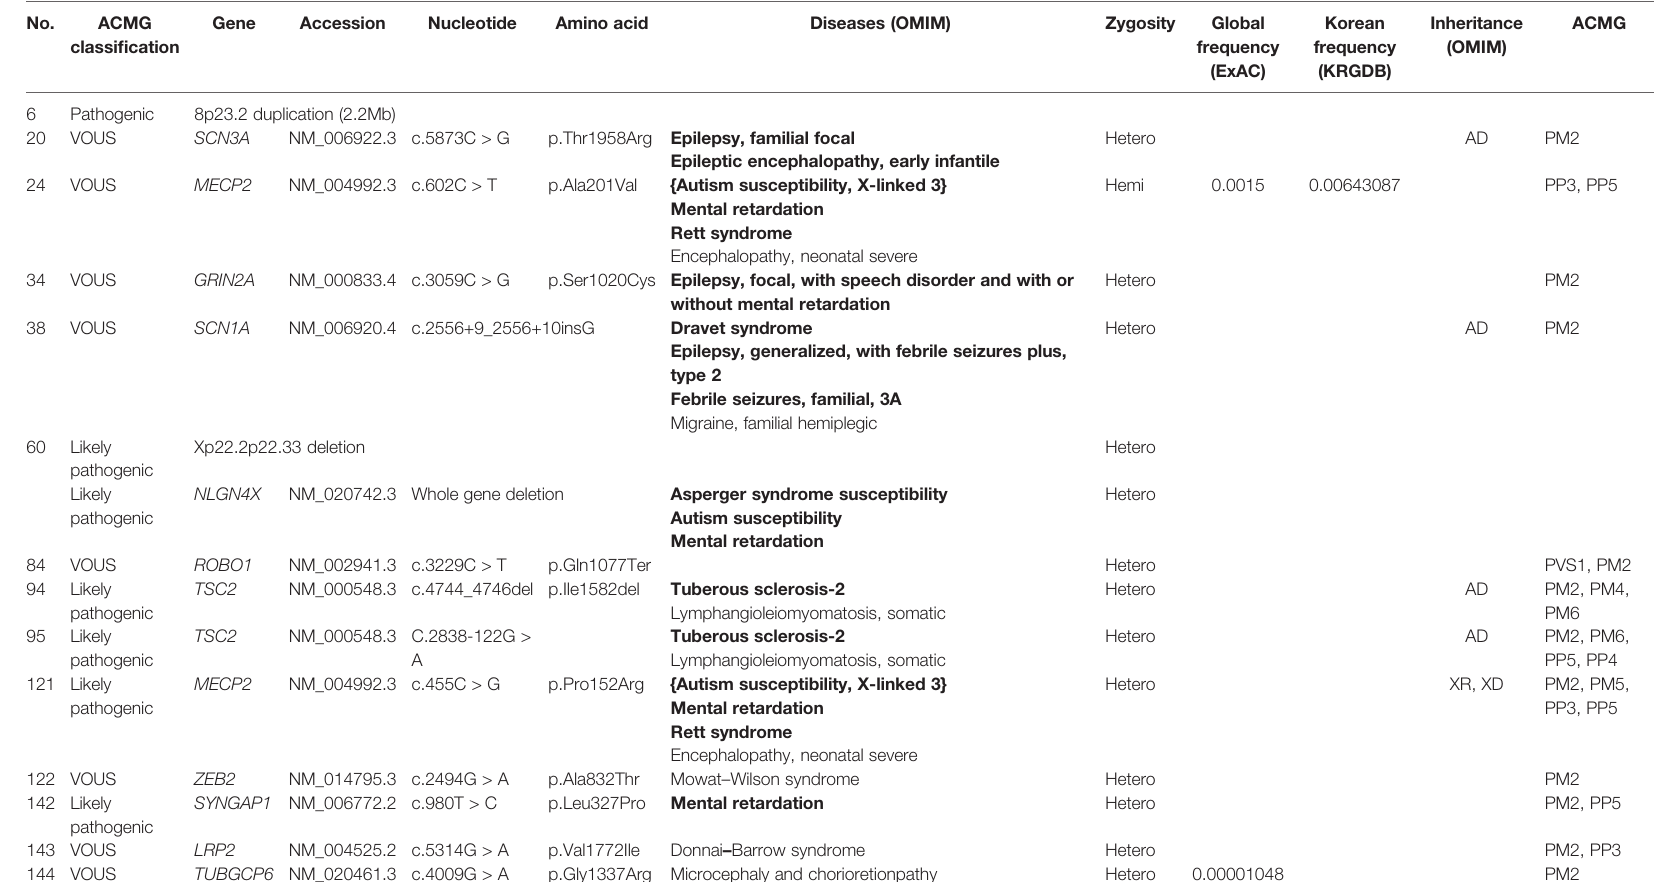
TABLE 5 | Genetic characteristics: genes with most suspected variants to be related to ASD with epilepsy.